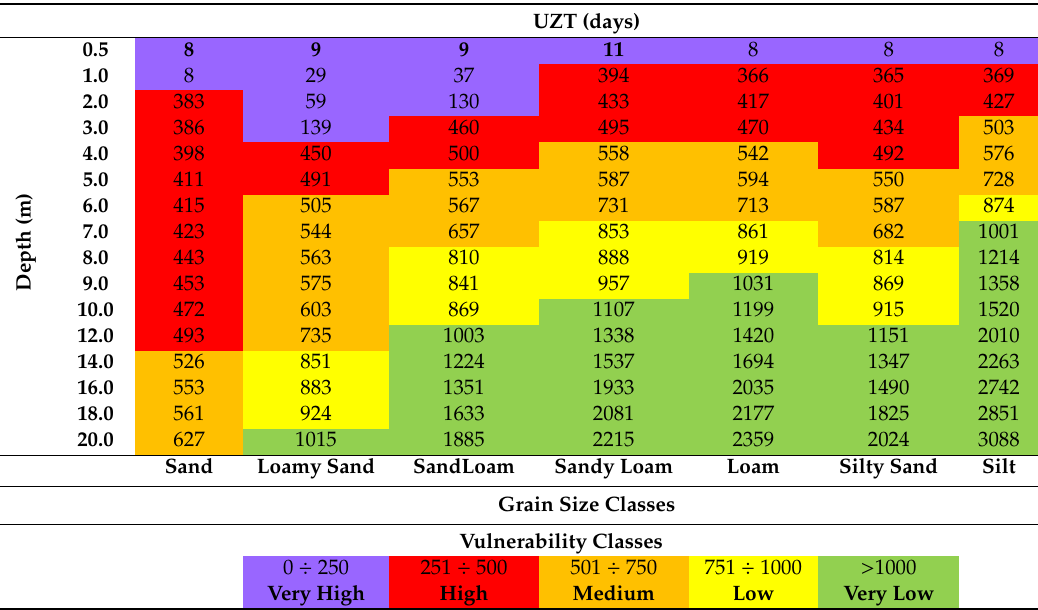
Table 3. UZT (days) estimated for di ff erent grain size classes and di ff erent depths of water table, down to 20 m. Lower table: groundwater vulnerability classes based on equal interval classification of UZT